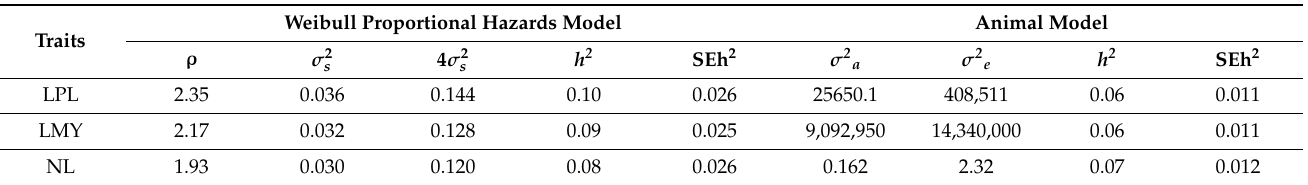
Table 3. Estimates for the additive genetic variance ( σ 2 a ), heritability ( h 2 ), and standard error (SEh 2 ) for the longevity traits.